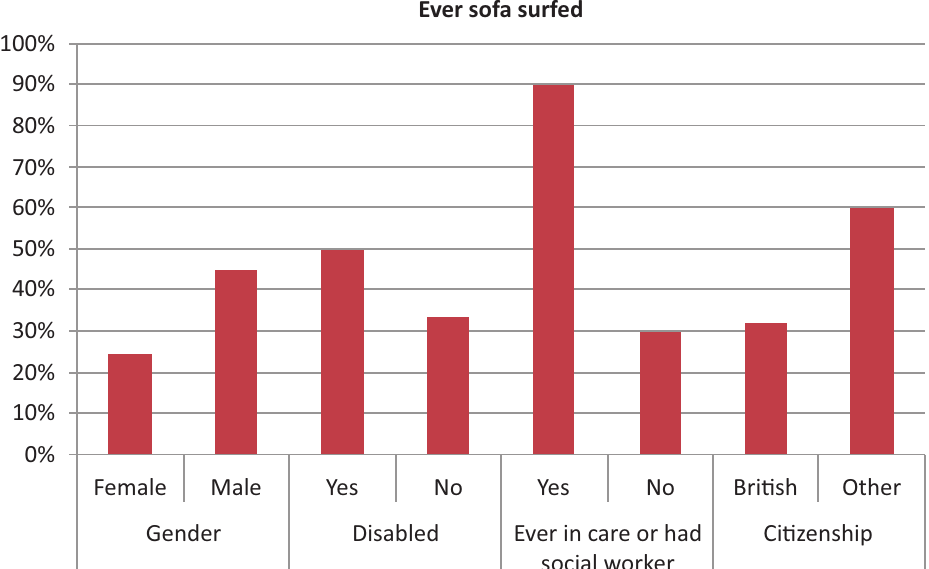
Figure 3. Extent of sofa surfing in different demographic groups, among people aged 16–24 identified as sofa surfing in the year to September 2014 5 . Source: Clarke et al. (2015). Table 6. Vulnerability indicators of young people who had slept rough or sofa surfers. Ever Ever All Proportion Proportion Proportion